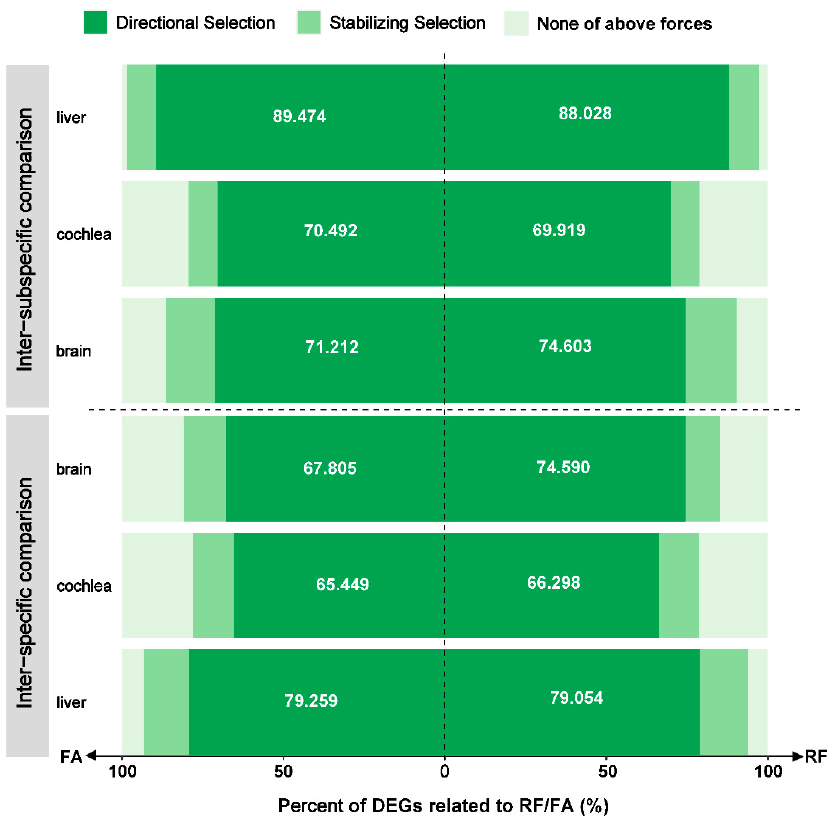
Figure 4. The ratio of trait-related differentially expressed genes (DEGs) whose expression